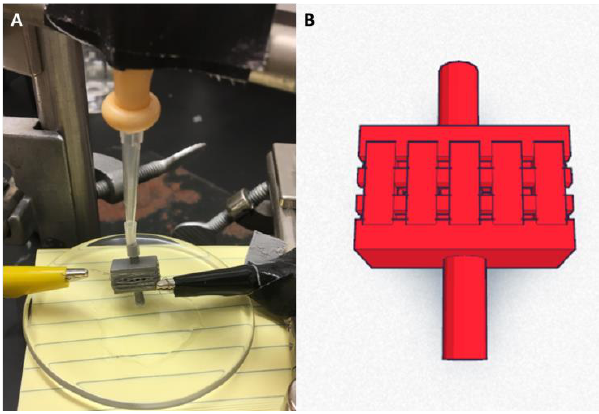
Figure 1. ( A ) Image of the 3D printed cartridge for ereptiospiration testing; and ( B ) screen shot of